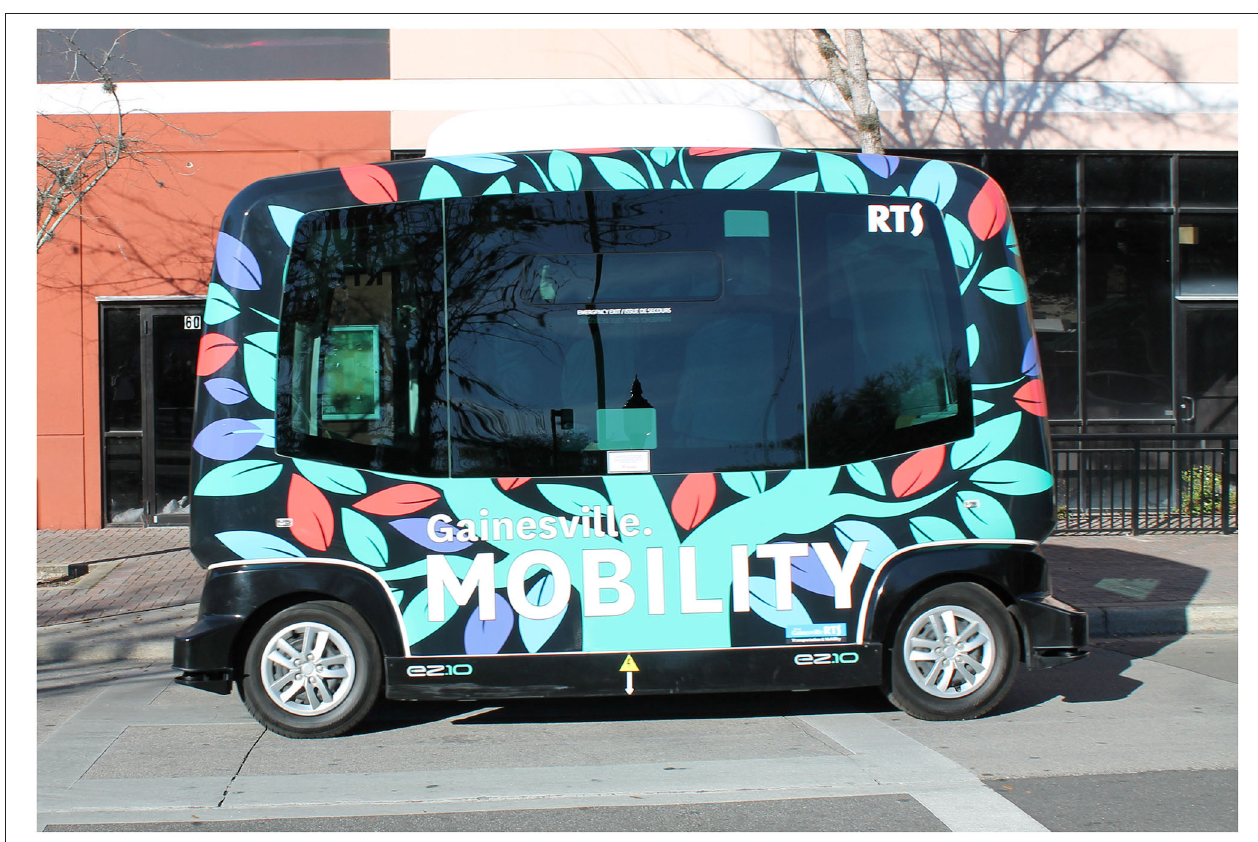
FIGURE 1 | The EasyMile EZ10 automated shuttle (SAE Level 4).